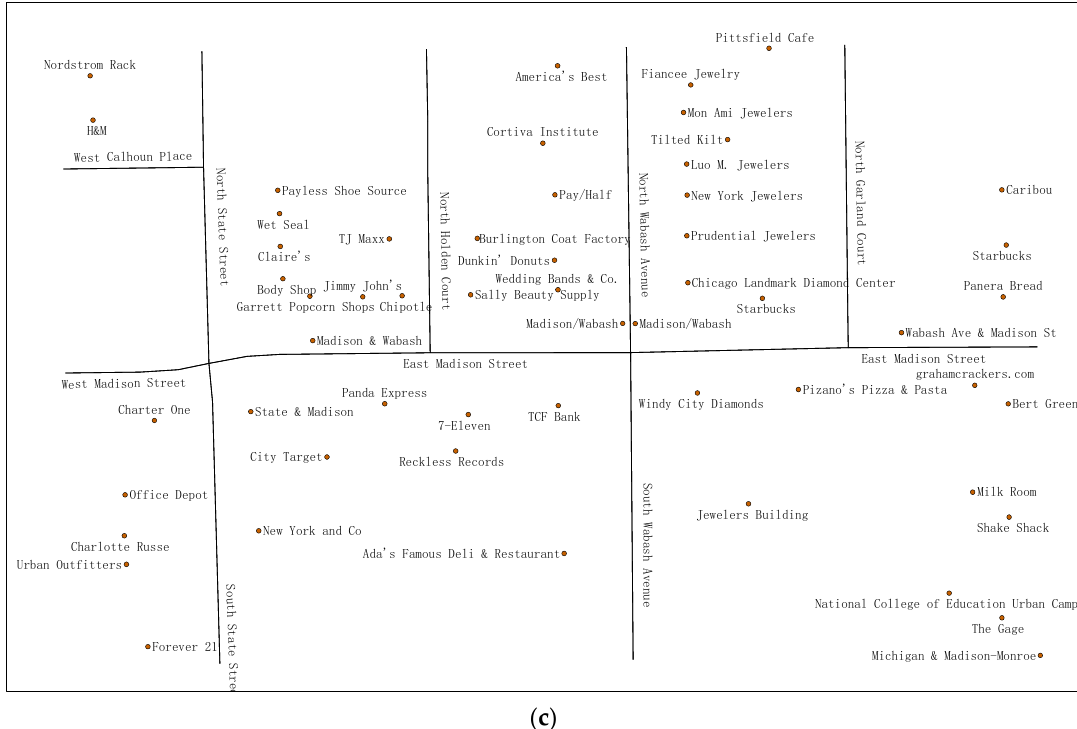
Figure 4. The progression of label placement with the DDEGA algorithm: ( a ) the initial random labeling of a generated map; ( b ) the map with label placement after 50 iterations of the algorithm; and ( c ) the final labeling of the map.